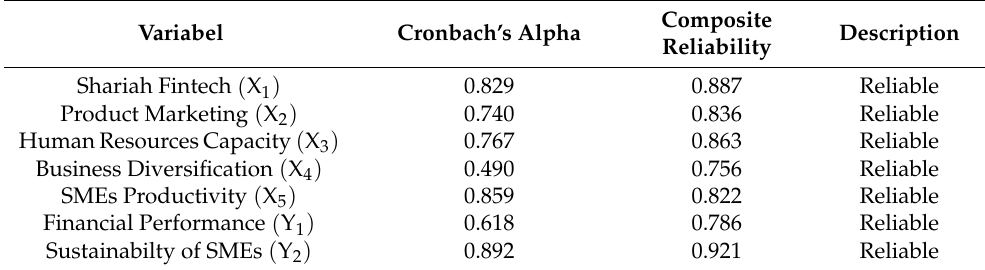
Table 5. Construct reliability test